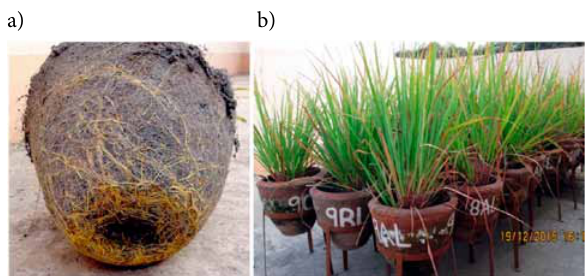
Fig. 7. Growth of lemon grass after 4 months of plantation (a), massive root growth of lemon grass which stabilizes the fly ash (b)